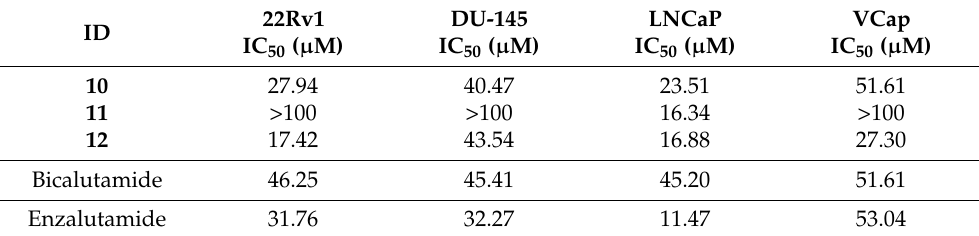
Table 1. In vitro antiproliferative activity of the sulfide analogues of bicalutamide ( 10 – 12 ) across four human prostate cancer cell lines (DU-145, 22Rv, LNCaP, and VCap). All data are mean values from experiments carried out on three separate occasions.